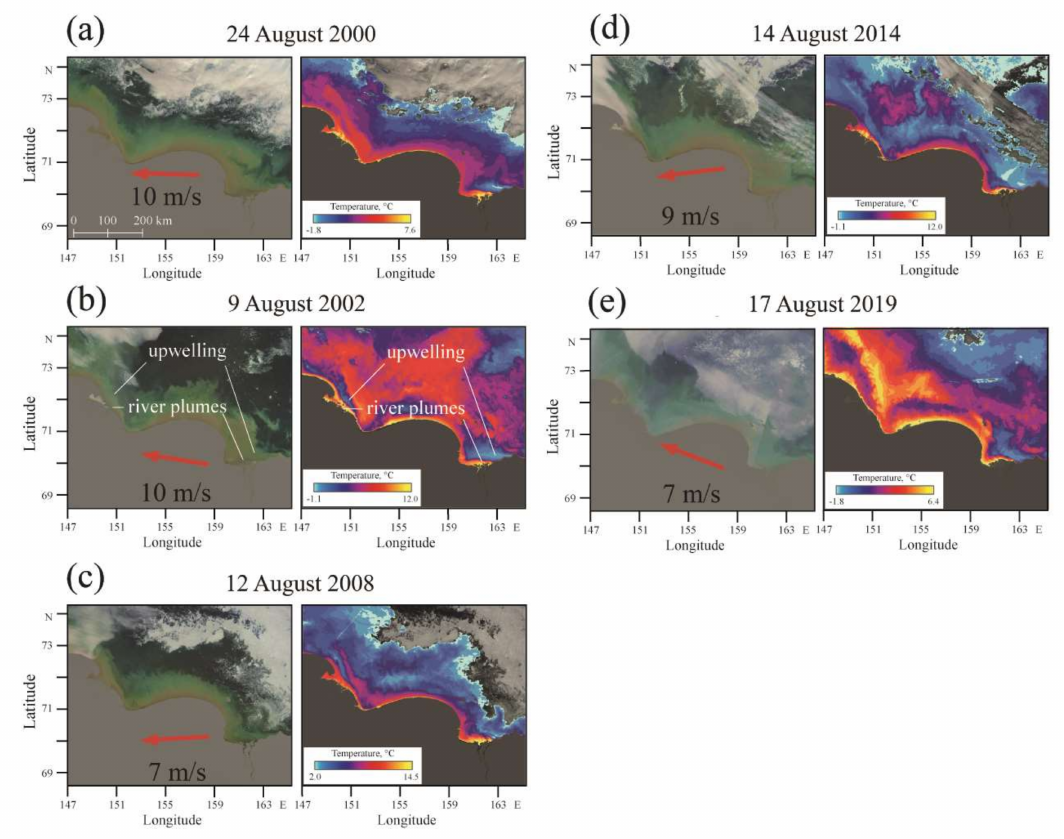
Figure 6. Corrected reflectance (left) and brightness temperature (right) from MODIS Terra and MODIS Aqua satellite images of the East-Siberian Sea acquired on ( a ) 24 August 2000, ( b ) 9 August 2002, ( c ) 12 August 2008, ( d ) 14 August 2014 and ( e ) 17 August 2019, indicating location of upwelling events to the north of the Indigirka and Kolyma deltas induced by wind forcing (arrows) and manifested by elevated sea surface turbidity and reduced sea surface temperature. Surface manifestations of upwelling events and river plumes are indicated at panel ( b